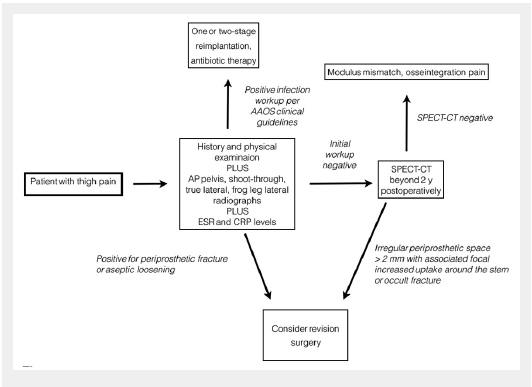
Diagnostic algorithm for thigh pain after total hip replacement (based on the American Academy of Orthopedic Surgeons Clinical Practice Guideline) [ 94]. AP = anteroposterior; CRP = C-reactive protein; CT = computed